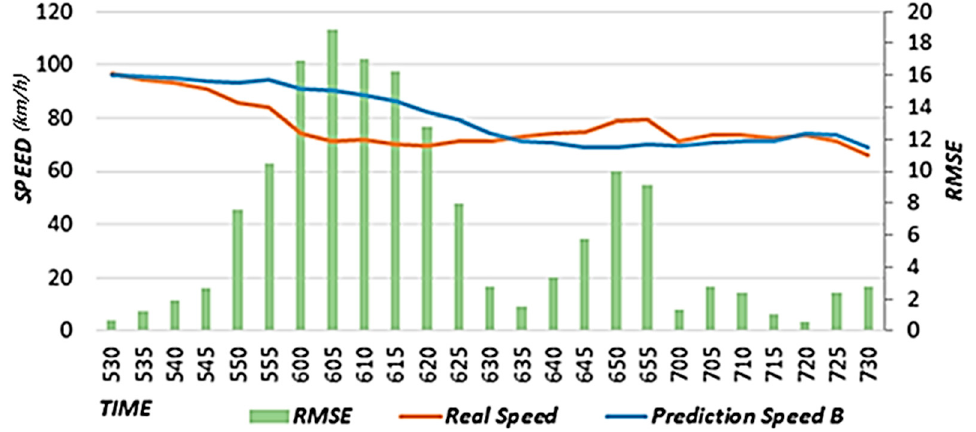
Figure 15. Prediction result without considering the historical average speed.